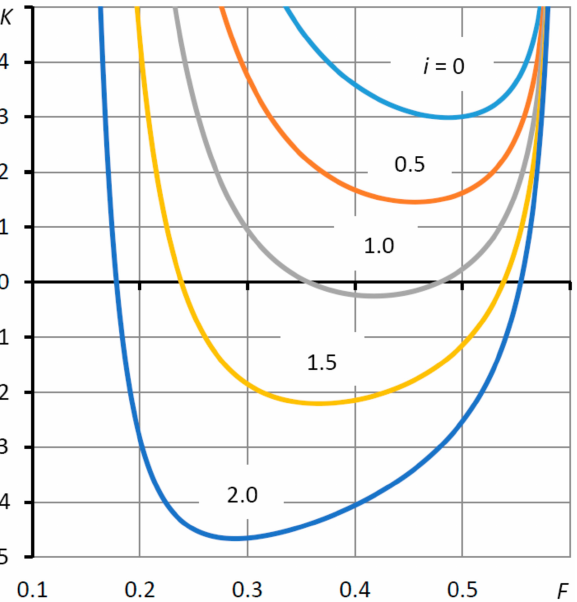
Figure 3. Dependences of compliance K on external force F at different values of the elasticity coefficient K e = i K e 0 .